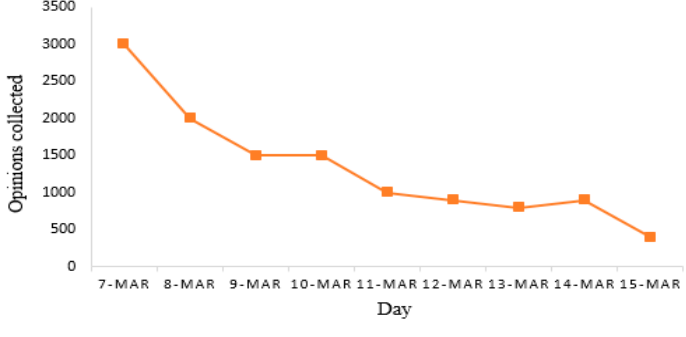
Figure 7. Number of opinions collected per day.